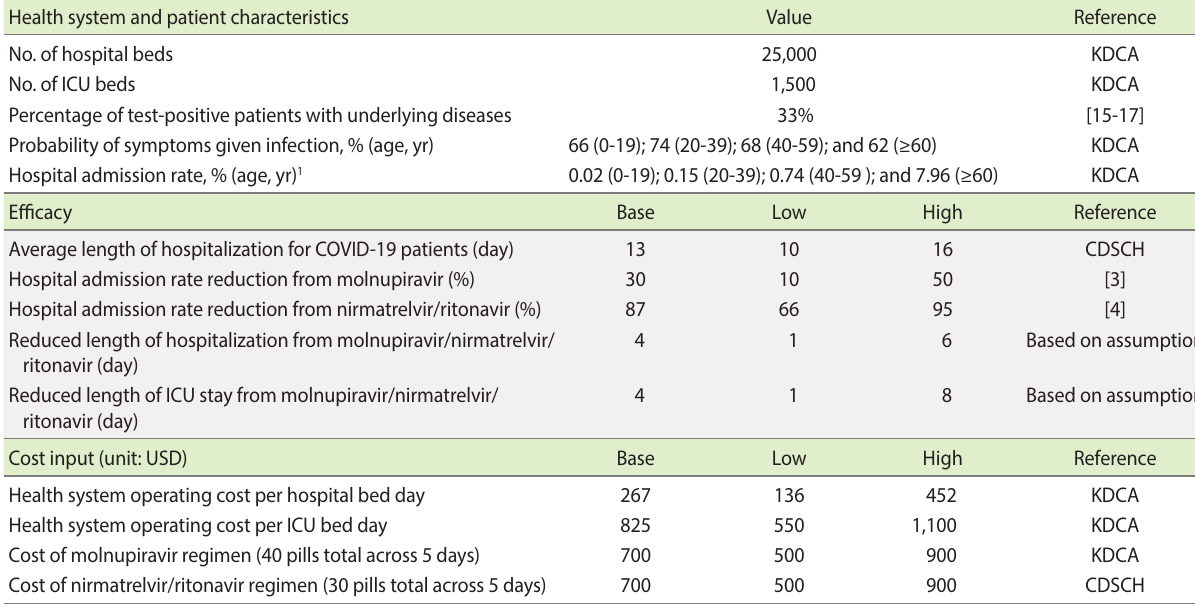
Table 1. Key input parameters Health system and patient characteristics